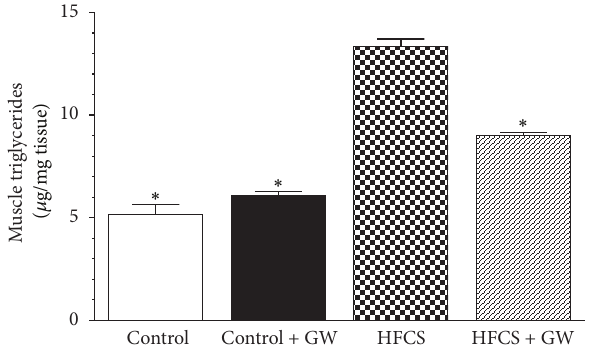
Figure 4: Triglyceride content in gastrocnemius of mice fed with a standard diet (control) or a HFCS diet (HFCS) for 30 weeks and treated with GW0742 (1mg/kg/day) added during the last 16 weeks (control + GW; HFCS + GW). Data are means ± SD of eight animals/group. ∗ 𝑃 < 0.01 versus